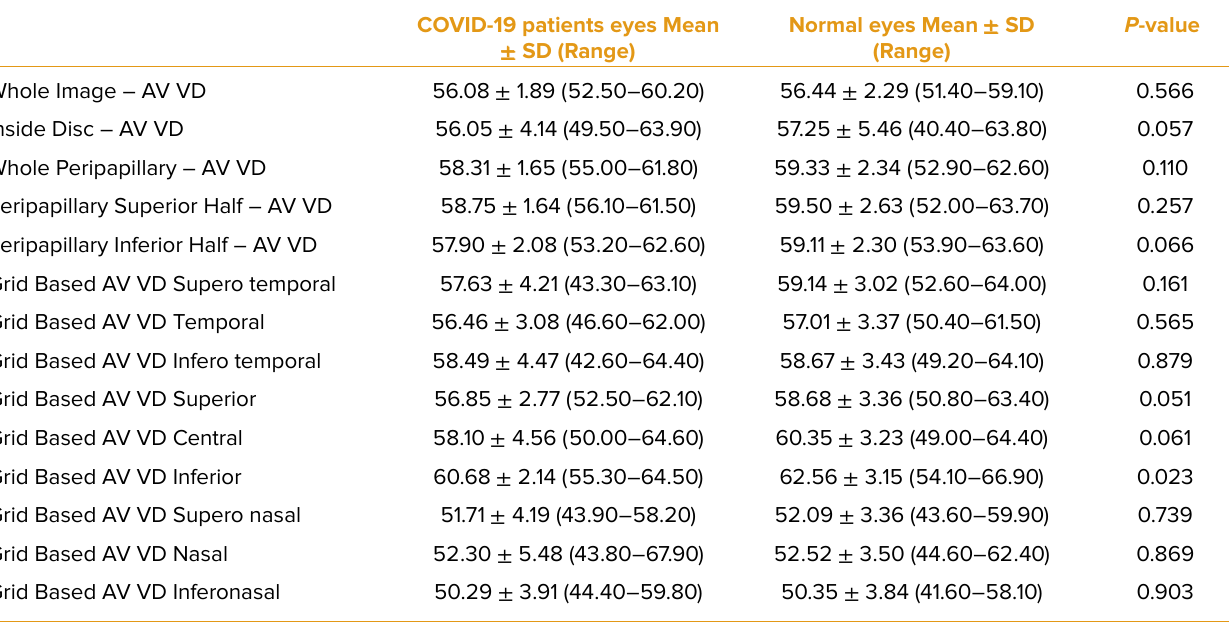
Table 3. Comparison of all vessels (AV), including both small and large vessels, vessel density (VD) of COVID-19 patients eyes versus normal eyes